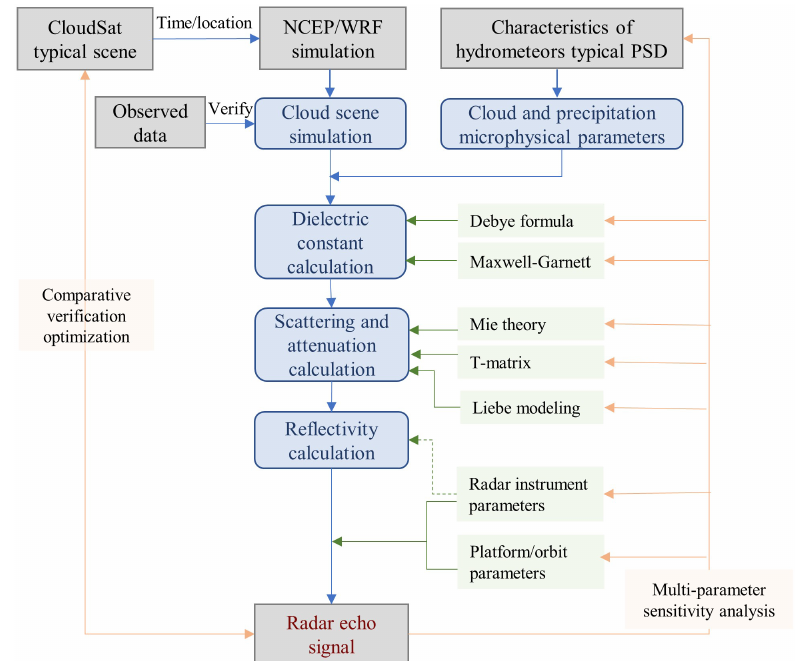
Figure 1. Submodule structure and framework of the simulation model.